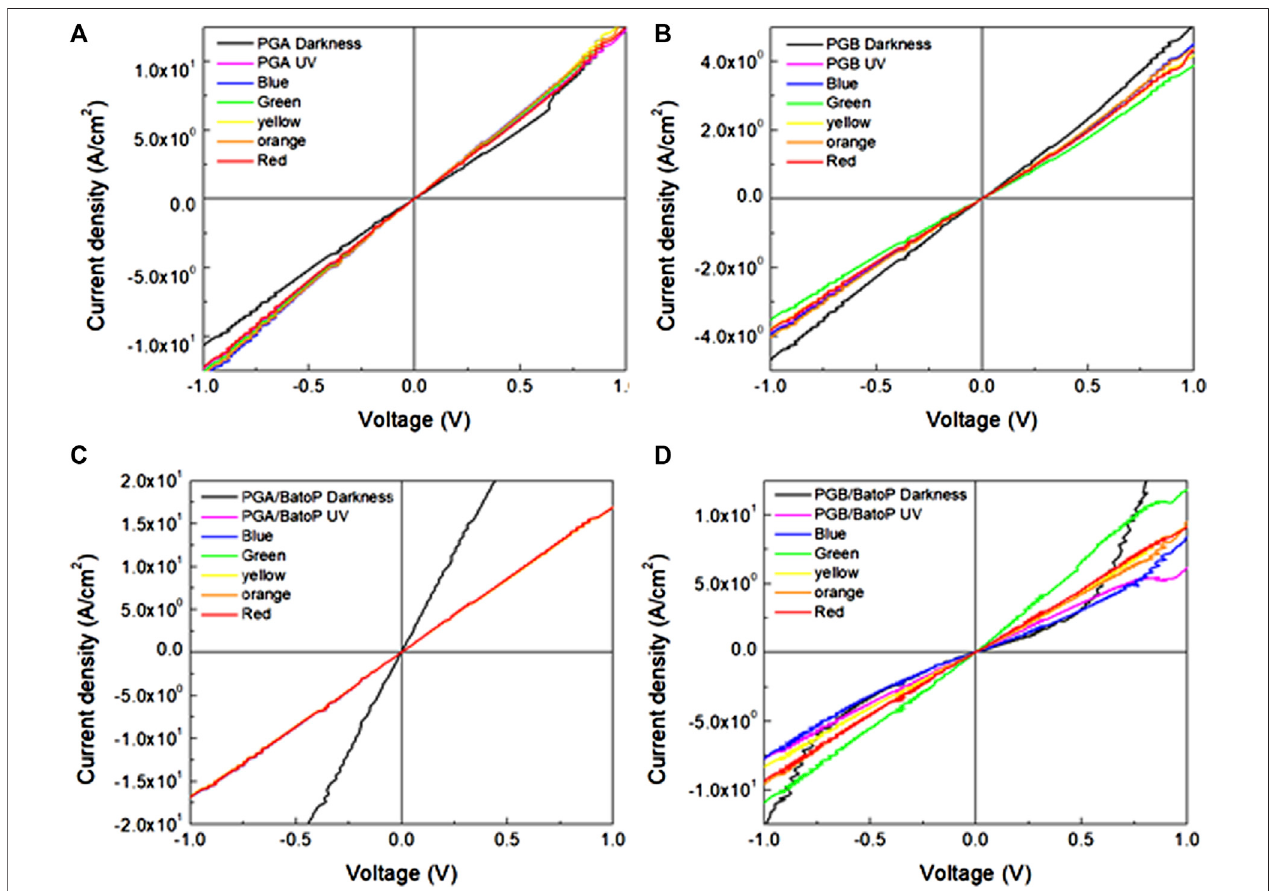
FIGURE 12 | Different light color exposure J – V curves for (A) PEDOT:PSS-graphene-a, (B) PEDOT:PSS-graphene-b, (C) PEDOT:PSS-graphene-a/BPhen, and (D) PEDOT:PSS-graphene-b/BPhen devices.